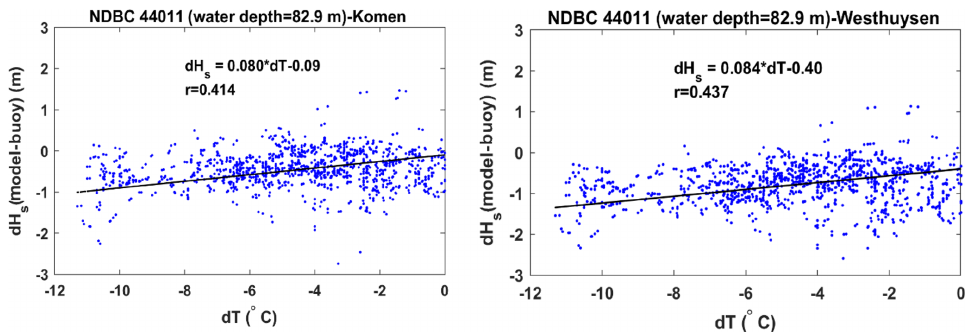
Figure 17. Correlation between the air–sea temperature difference and deviations of the simulated wave height from the measurements at NDBC 44011 for two whitecapping